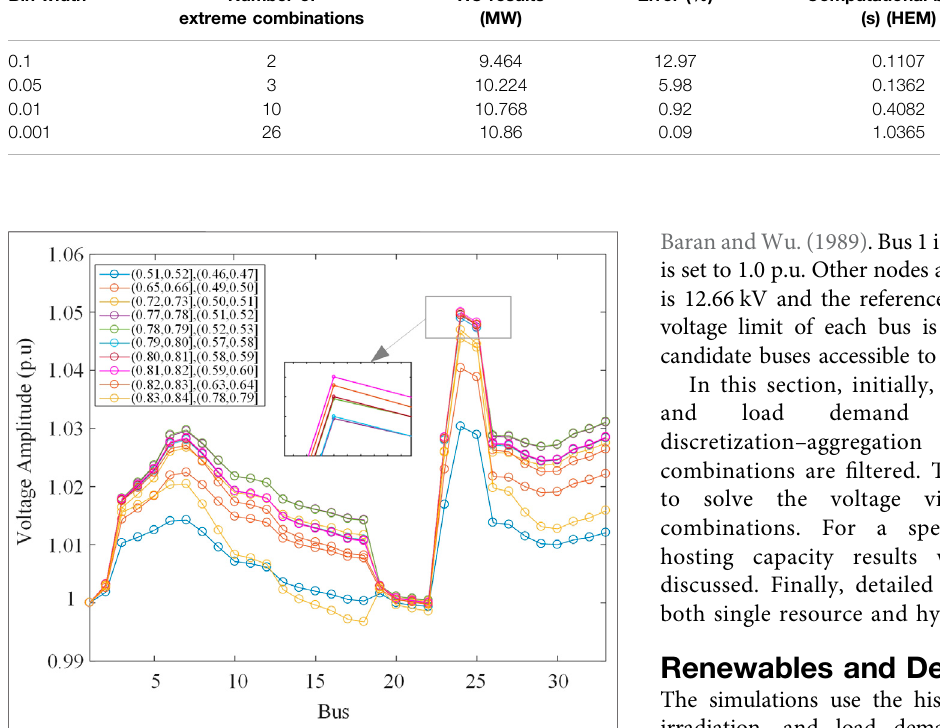
FIGURE 7 | Voltage violation scenarios.